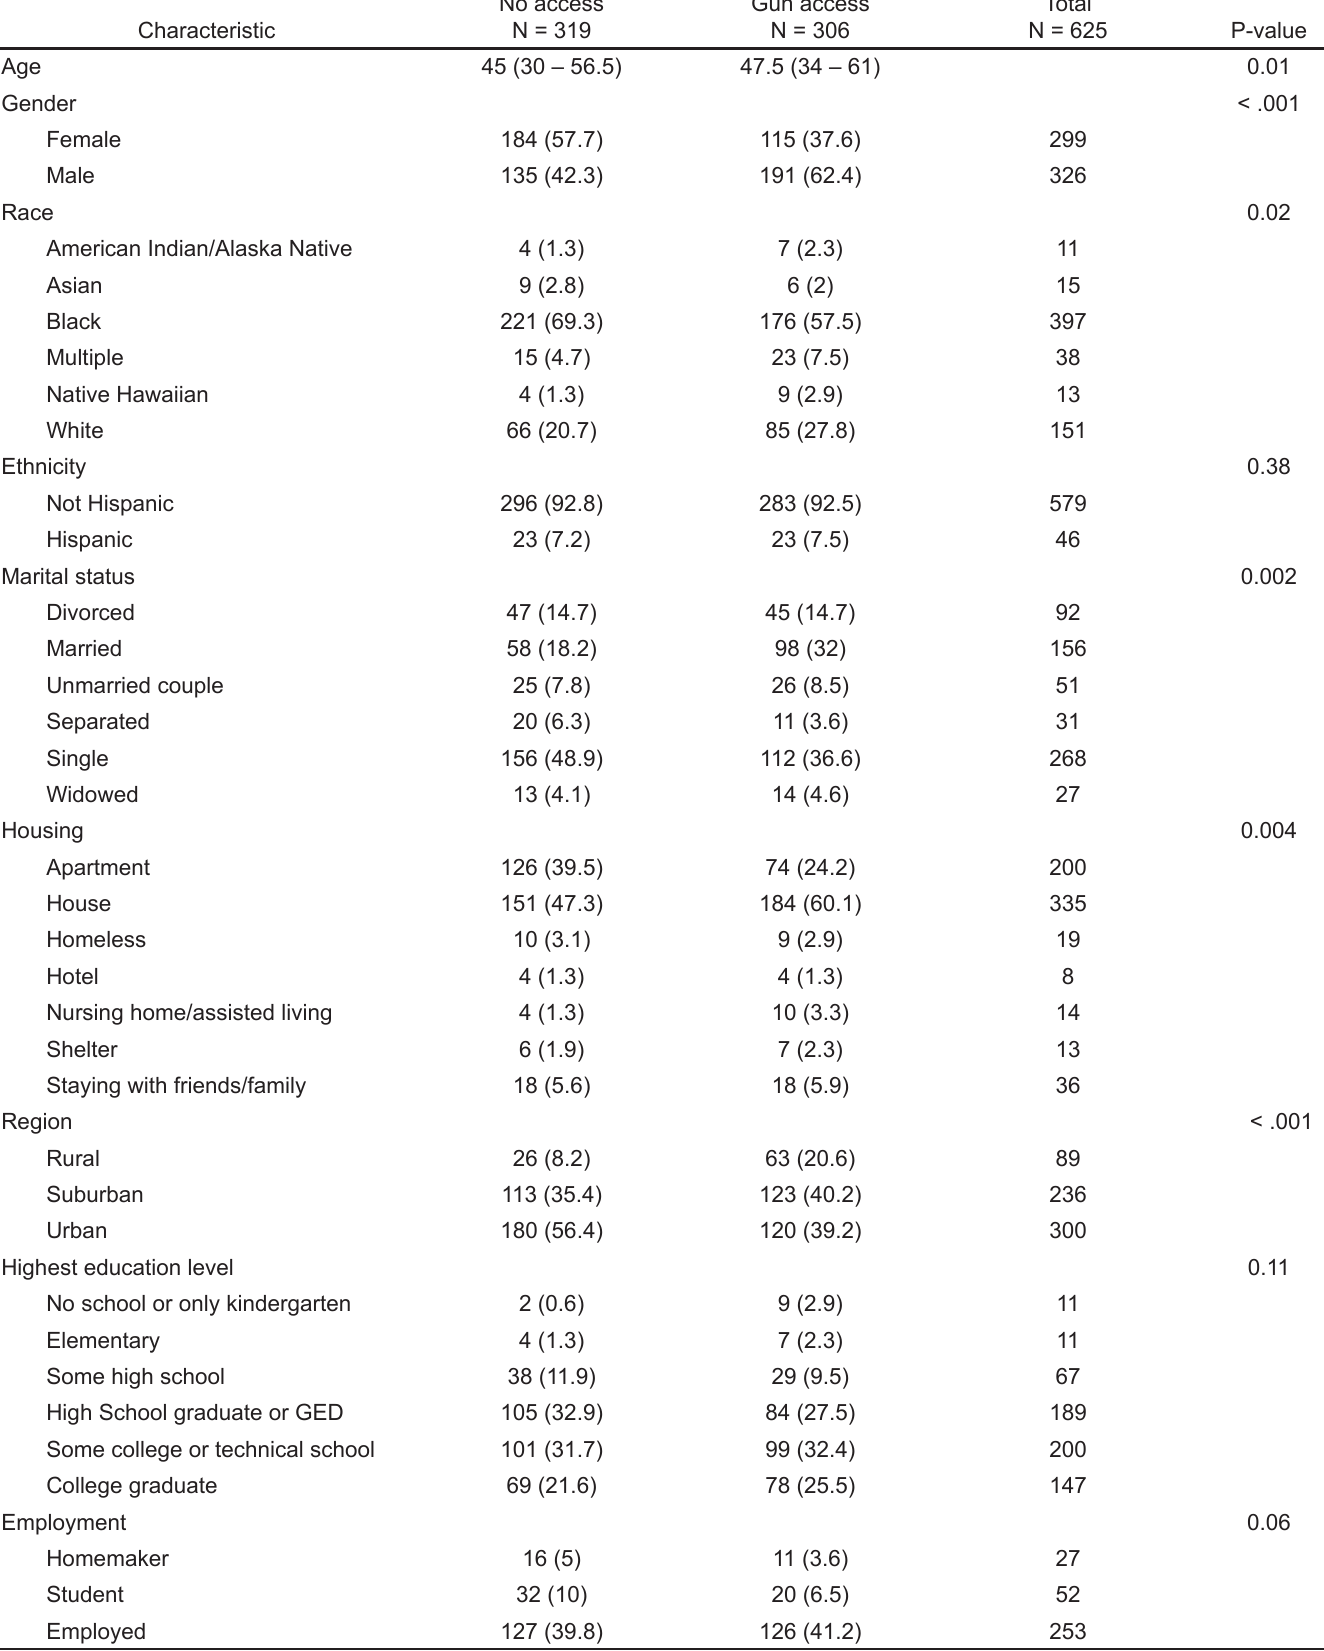
Table 1. Demographic characteristics of study participants, gun access vs no